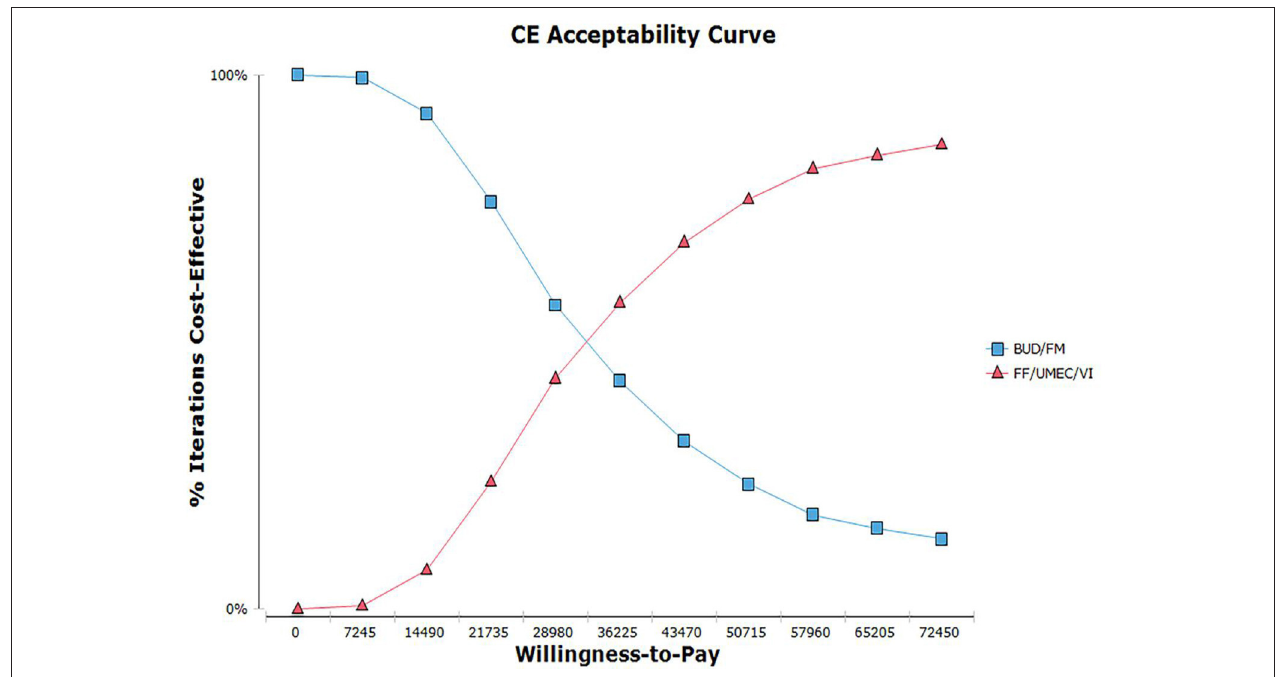
FIGURE 5 | Cost-effectiveness acceptable curve plotting. Willingness-to-pay vs. iterations cost-effective.